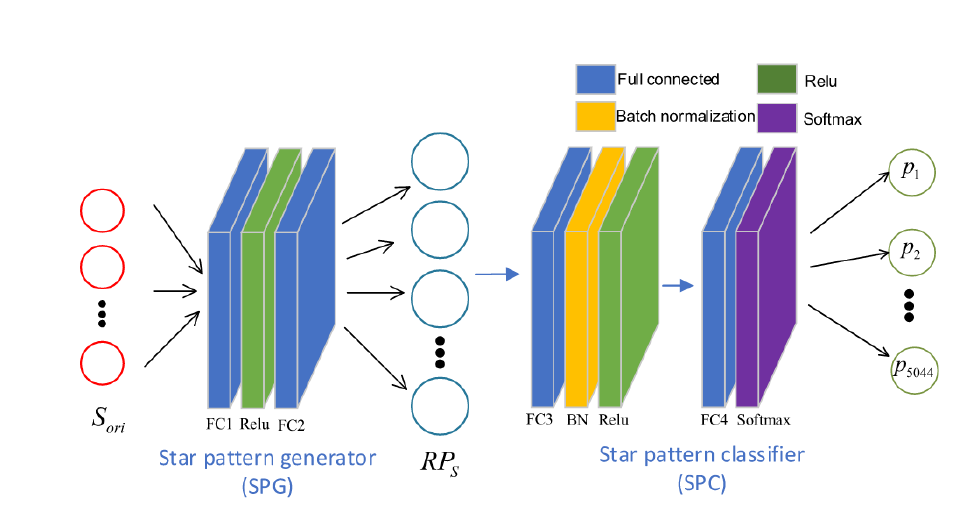
Figure 10. Structure of RPNet (reprinted from [24]).